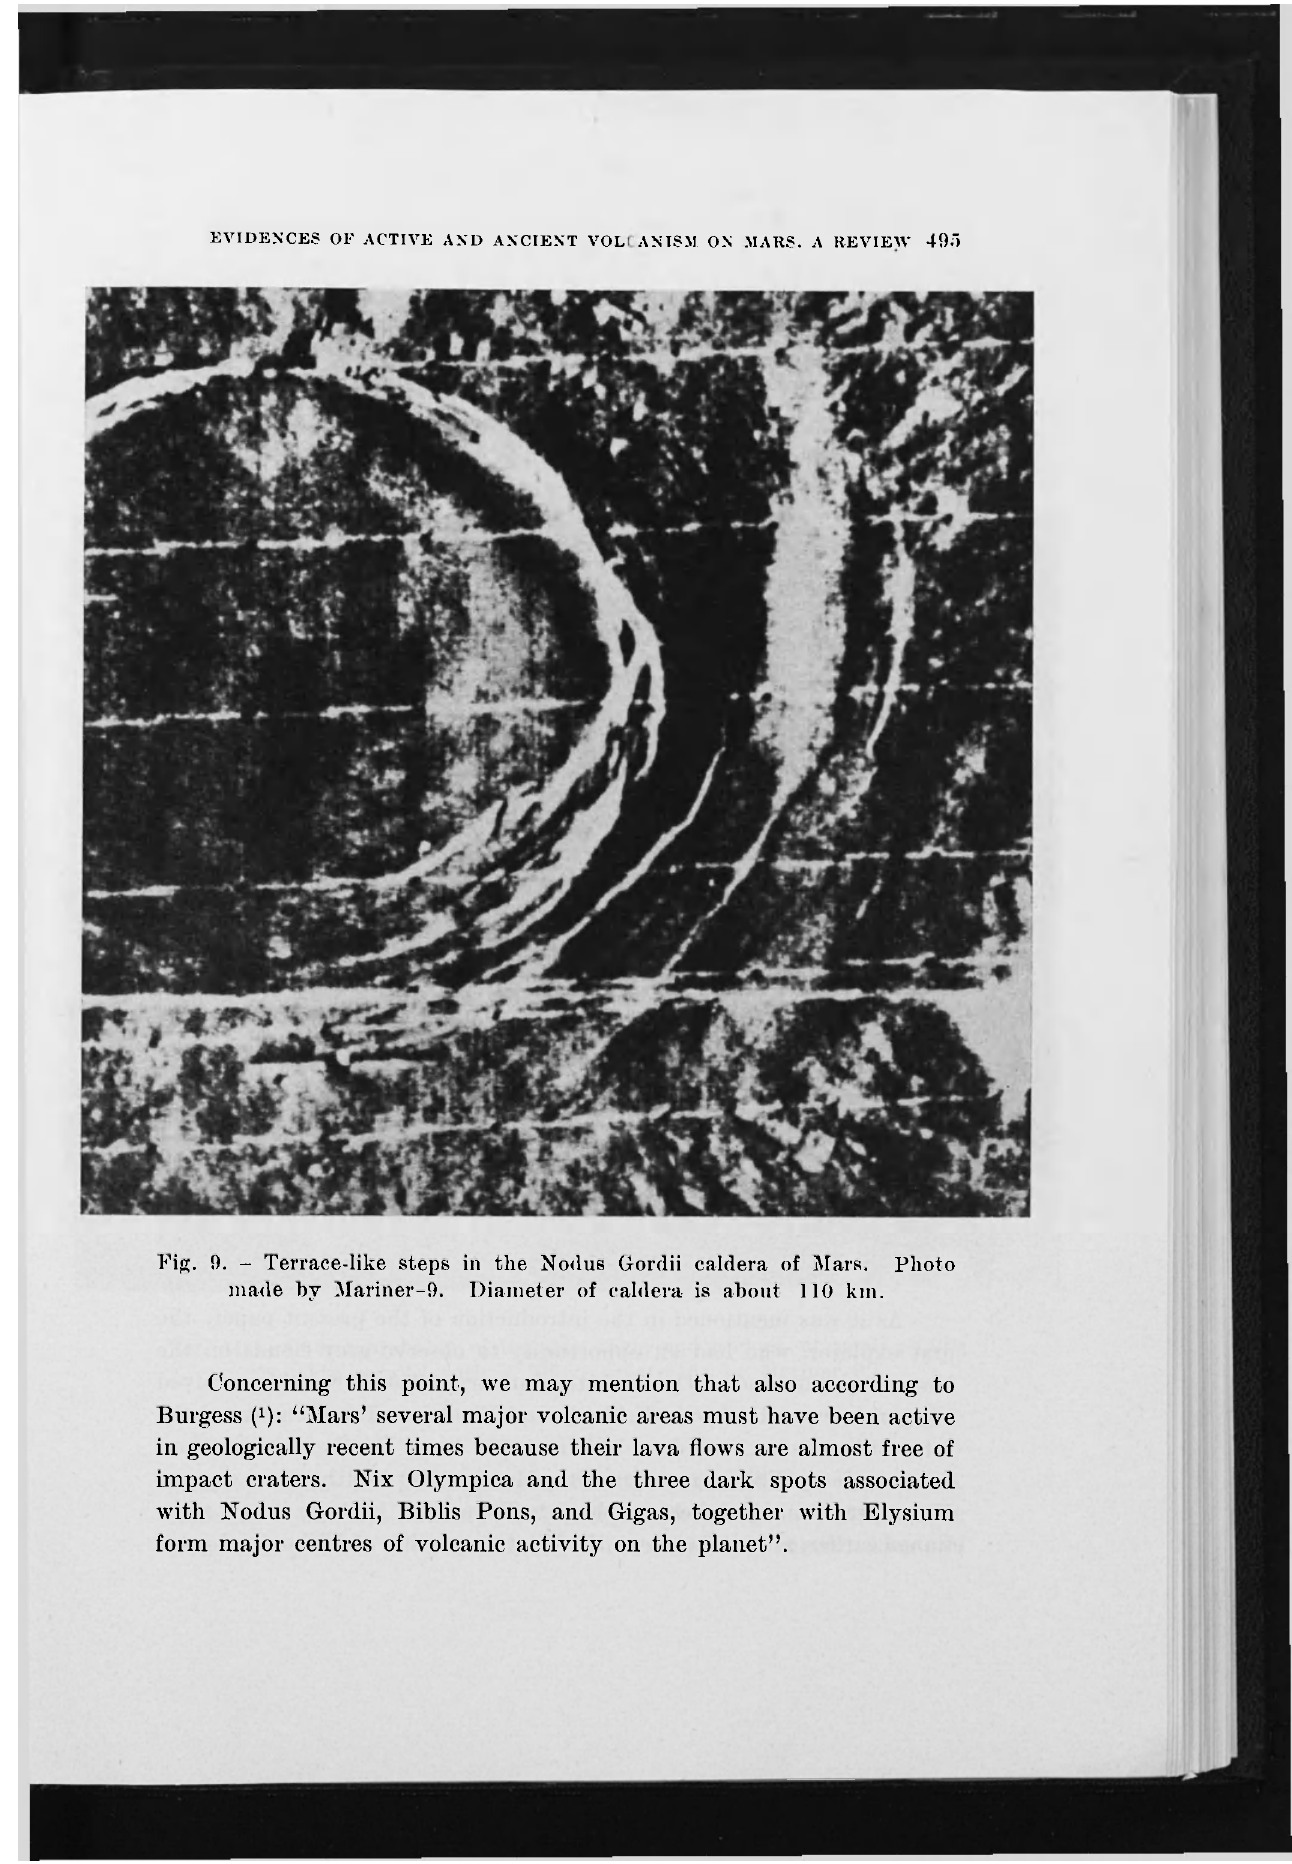
made by Mariner-9. Diameter of caldera is about 110